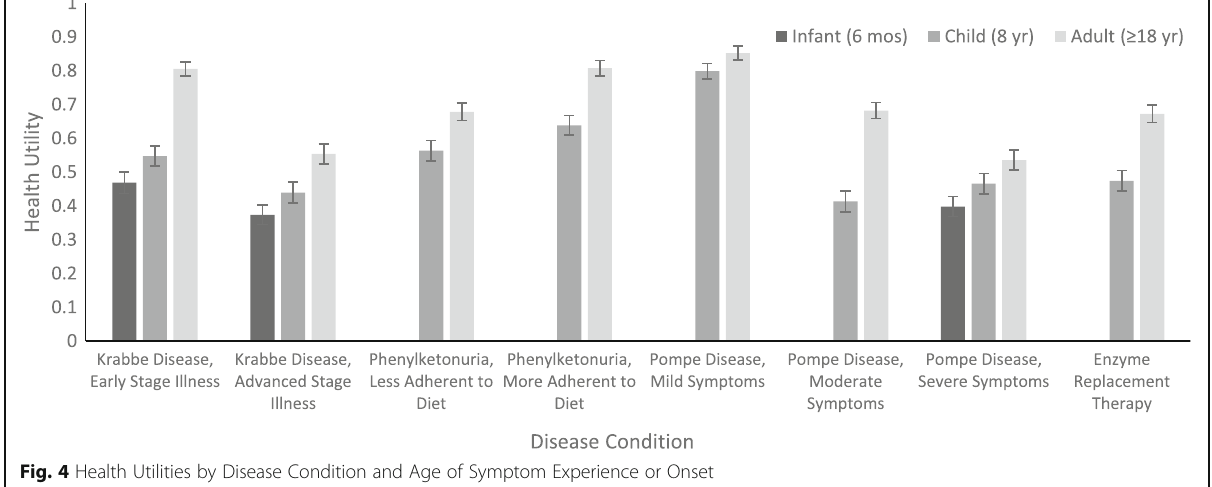
Fig. 4 Health Utilities by Disease Condition and Age of Symptom Experience or Onset